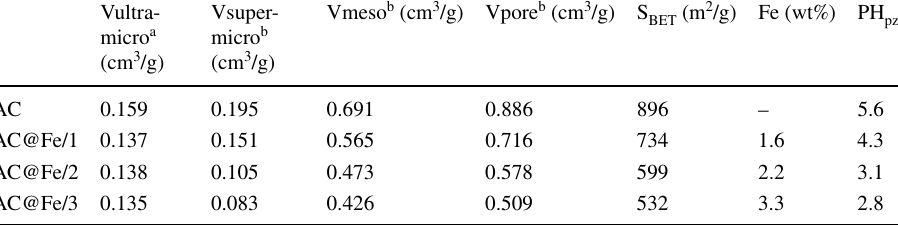
Table 2 Textural properties of pristine AC and the prepared heterogeneous